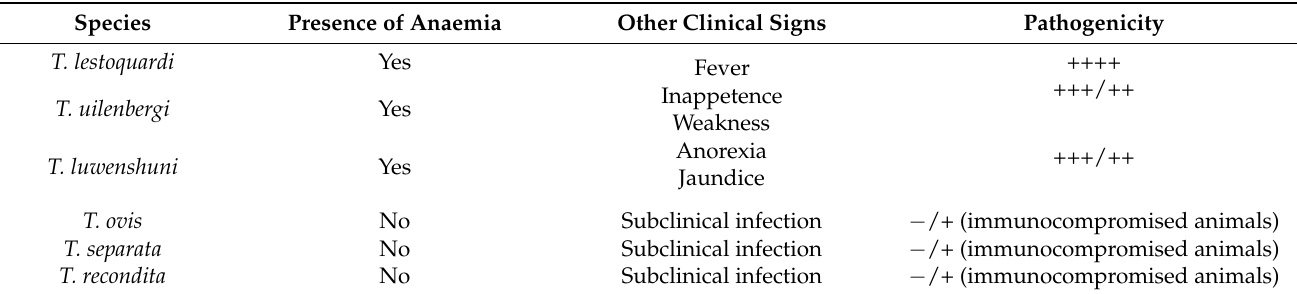
Table 2. Clinical signs associated with each Theileria